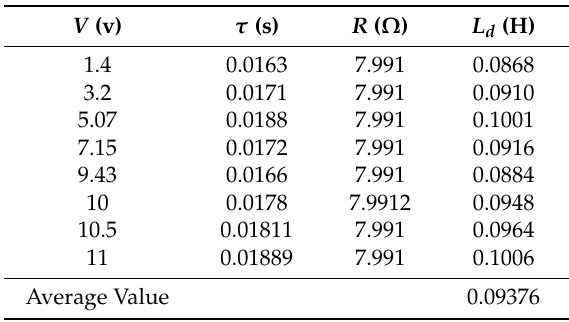
Table 6. Step DC test result rotor d-axis aligned with phase-a.